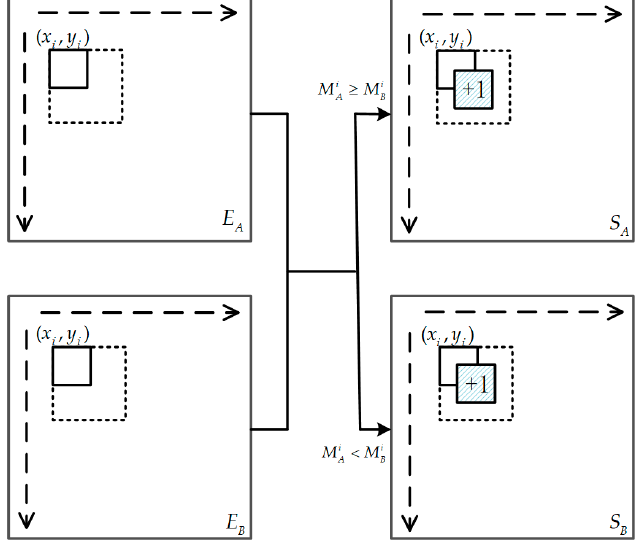
Figure 2. ( a ) Source image I A ; ( b ) source image I B ; ( c ) low-scale image I LL ; ( e ) clarity score map S A ; ( f ) clarity score map S B .